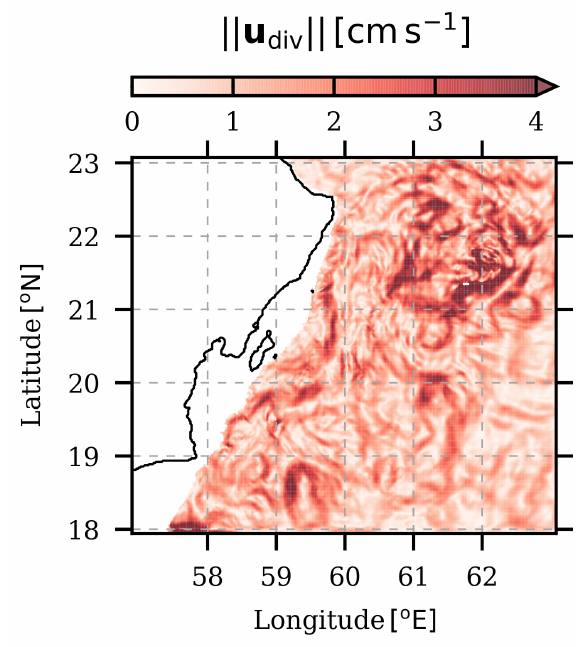
Figure A1. Divergent part of the velocity computed on the same day as in Figure 8 at 360 m